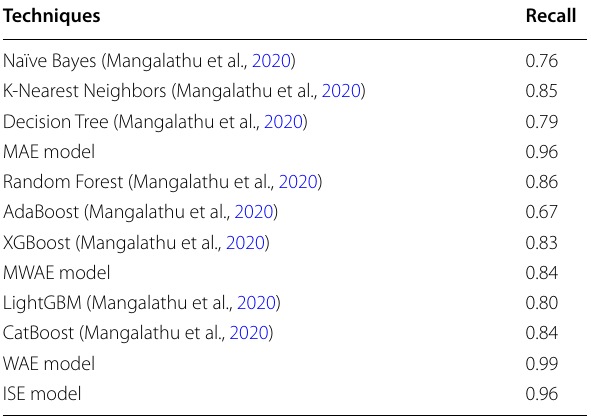
Table 8 Weighted-average recall of various